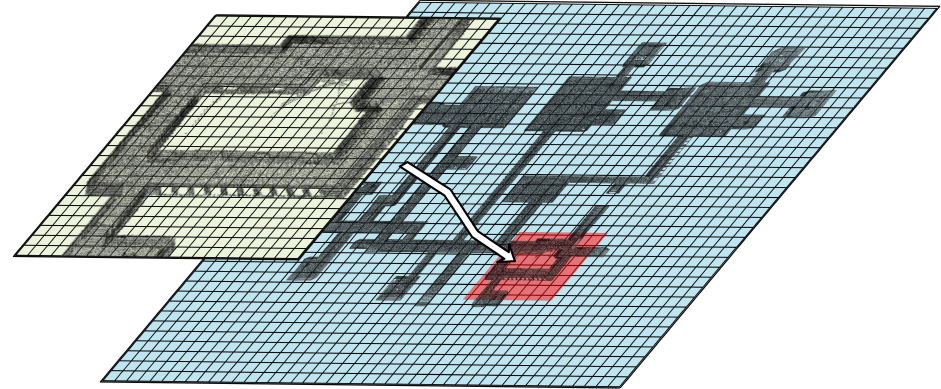
Figure 8. A two-layer update structure, where the blue grid is the global map, and the turquoise grid is the local map. The local map is located in the red boxed area in the global